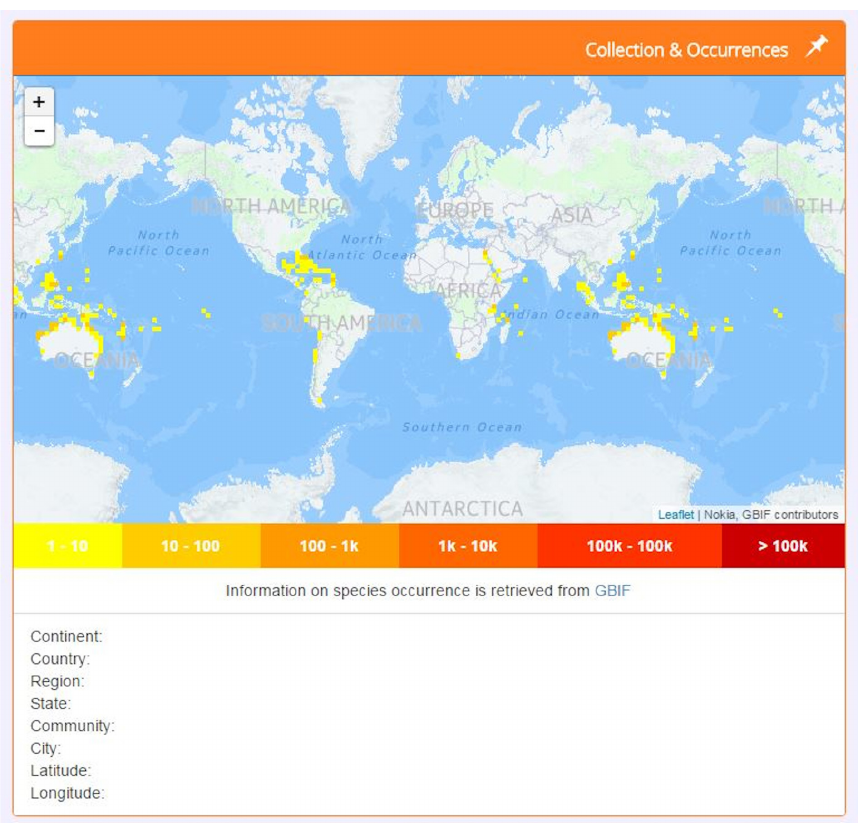
Fig. 2.26. Plane 5 of the specimen page at Zoosphere.net, showing the distribution of the specimen’s species, as retrieved from GBIF. Image copyright